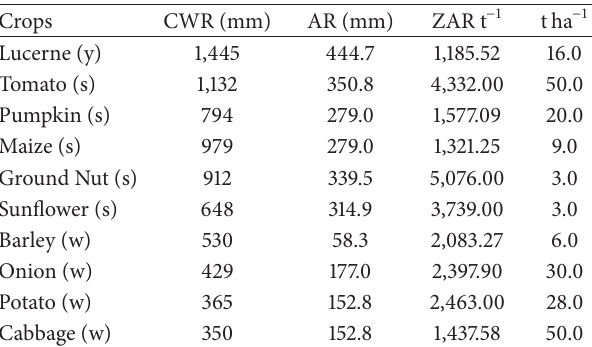
Table 1: Crop and average rainfall